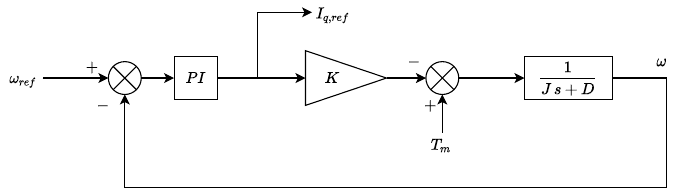
Figure 3. Mathematical block-diagram for I q and ω